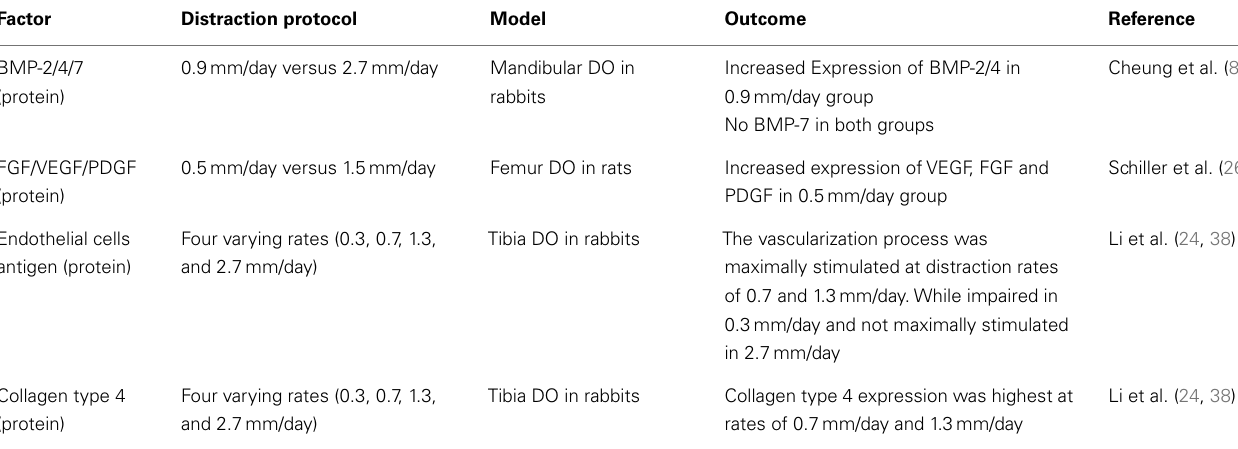
Table 4 | Factor expression in variable distraction rates and rhythms of distraction osteogenesis